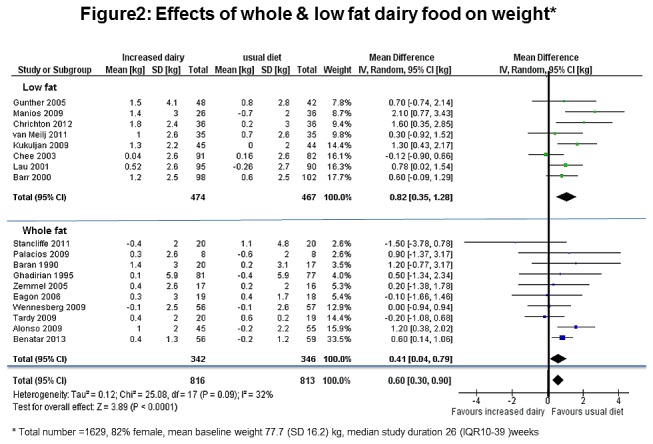
Effects of whole & low fat dairy food on weight.